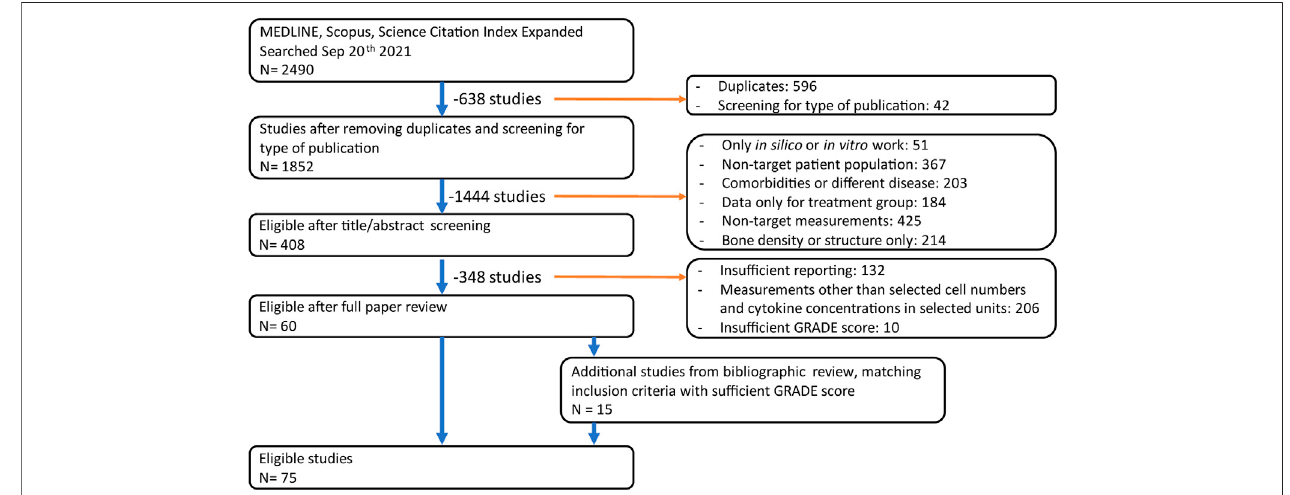
FIGURE 1 | PRISMA diagram illustrating the effect of each inclusion/exclusion